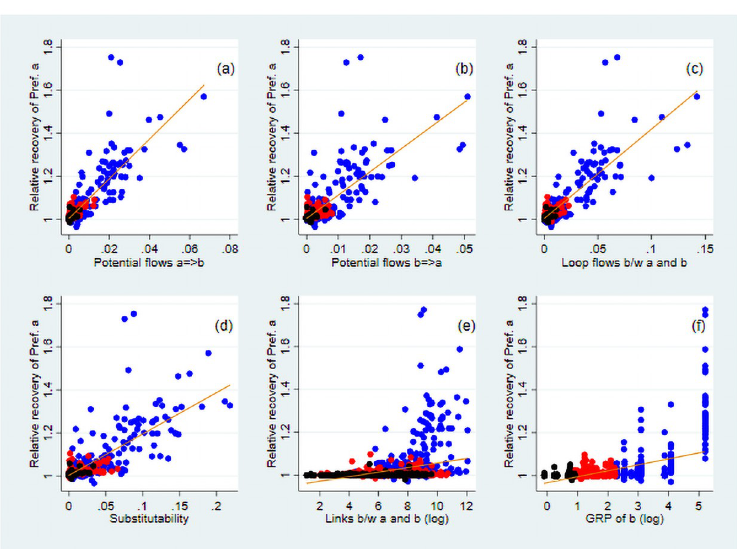
Fig 5. Correlation between the relative recovery and selected network measures. The vertical axis indicates the relative recovery of prefecture a , defined as the ratio of the increase in the GRP of prefecture a by lifting its lockdown together with prefecture b to its increase by lifting its lockdown alone. The effect of the GRP of b and total links between the two are excluded from the relative recovery measure. The variable in the horizontal axis is given by Eqs 3 and 4 in panels (a) and (b), respectively, Eq 5 in (c), the share of substitutable suppliers in b for those in a among a ’s locked-down suppliers in (d), the number of links between prefectures a and b in (e) and the GRP of b in logs in (f). The orange line in each panel signifies the fitted value from a linear regression that controls for the effect of the GRP of b and total number of links between a and b in (a)–(d). The blue, black, and red dots show the pairs of prefectures a and b for which the GRP of b is among the top 10, bottom 10, and others, respectively.